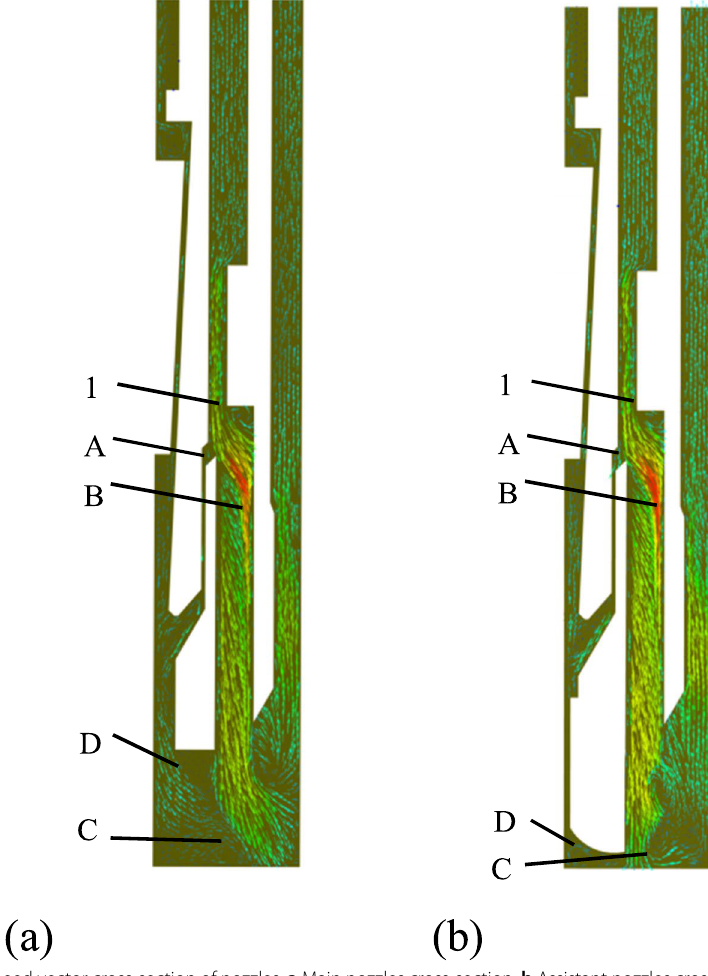
Fig. 7 Speed vector cross-section of nozzles. a Main nozzles cross-section. b Assistant nozzles